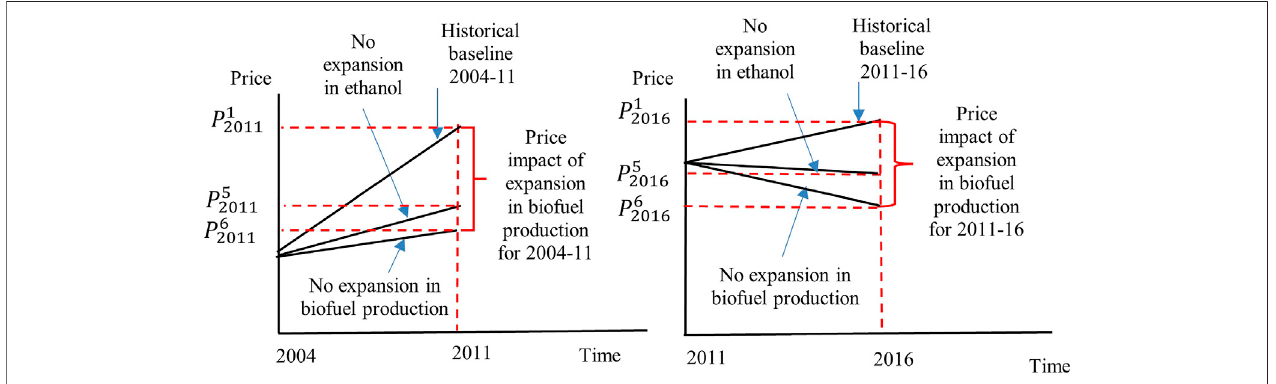
FIGURE3| Aschematicrepresentationofhistoricalbaselinesandcounterfactualexperimentsincluding: Noexpansioninethanol and Noexpansioninbiofuels .The left panel represents 2004 – 11 and the right panel illustrates 2011 – 16. The vertical axis shows the price of a representative product. P 1 , P 5 , and P 6 show the projected prices of this product for the historical baselines , No expansion in ethanol and No expansion in biofuels, respectively.